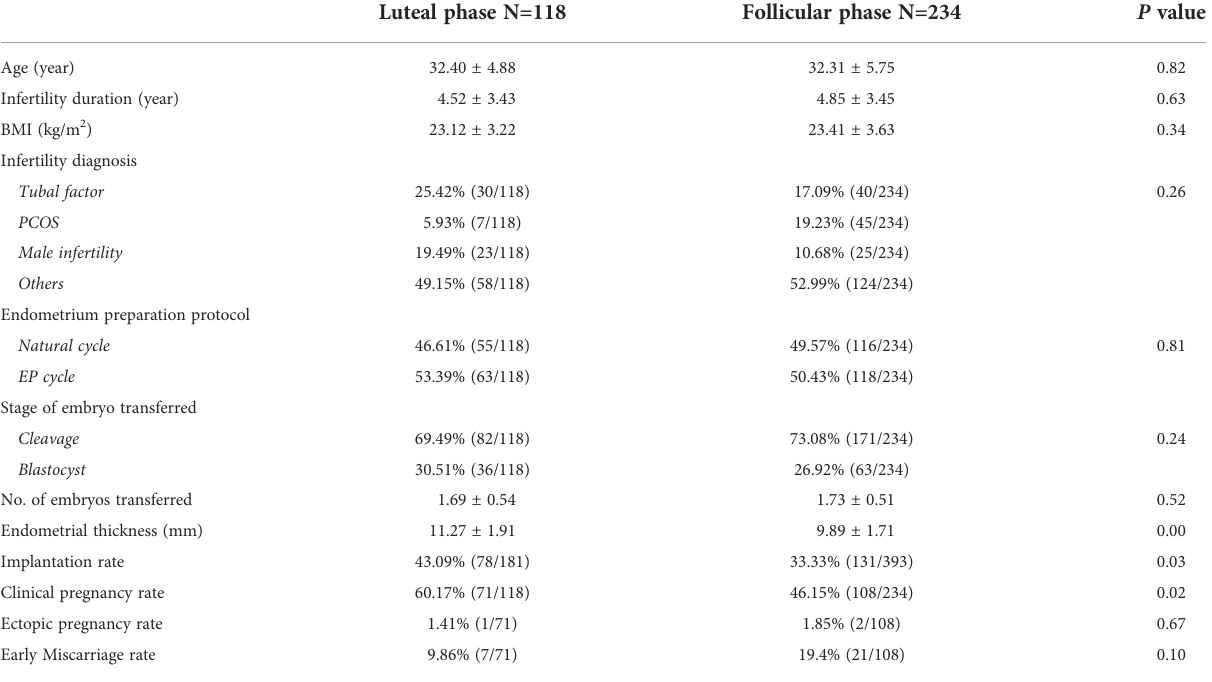
TABLE 2 Basic parameters and clinical pregnancy outcomes in patients with ≥ 2 failed transfer cycles.